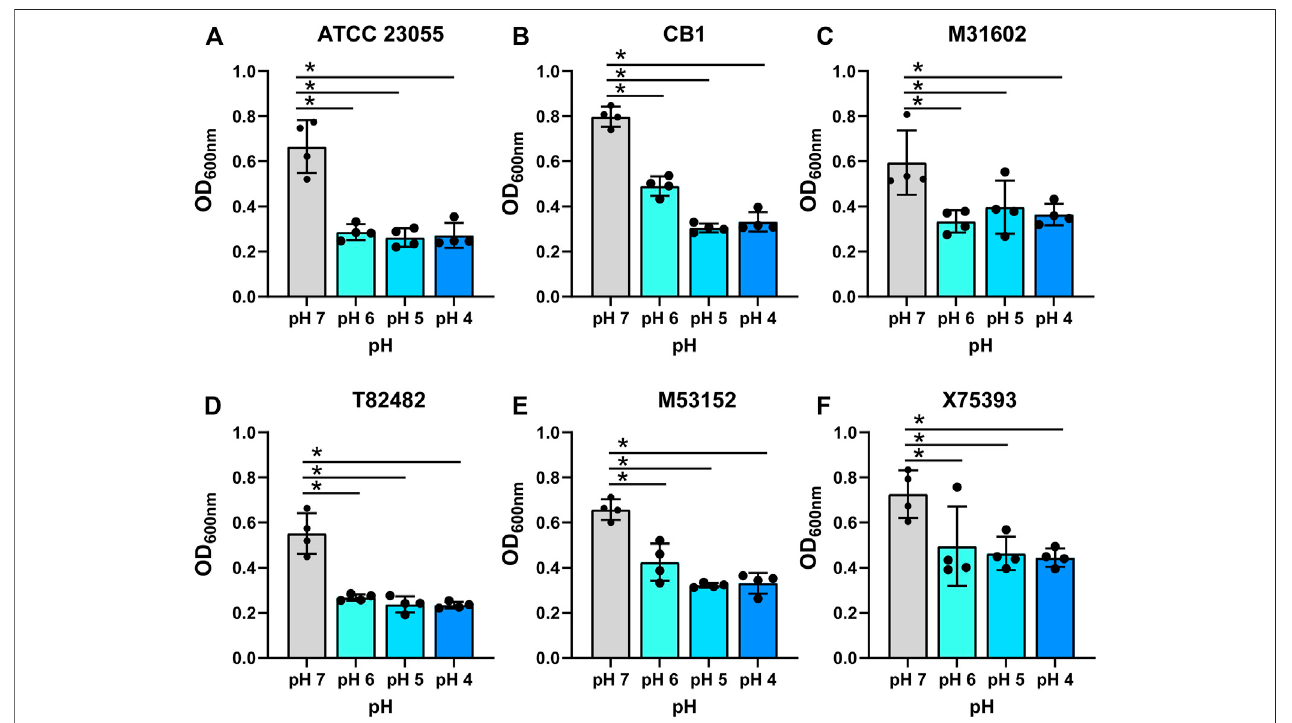
FIGURE 1 | Growth of (A) calcoaceticus in various pHs. Growth of A. calcoaceticus strains as measured by OD 600nm after 18 h of incubation. Growth was examined in the following strains: (A) ATCC 23055, (B) CB1; clinical isolates: (C) M31602, (D) T82482, (E) M53152, and (F) X75,393). * p < 0.05, One Way ANOVA.